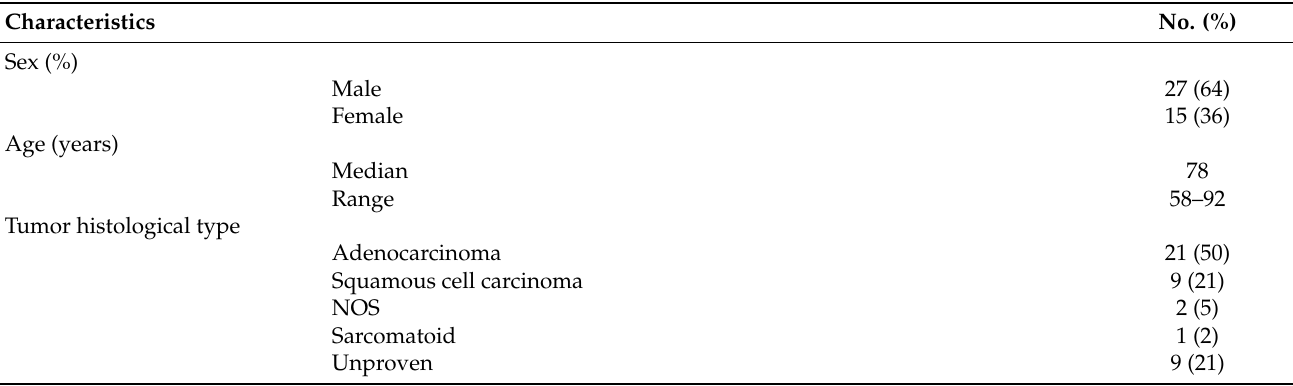
Table 1. Characteristics of the